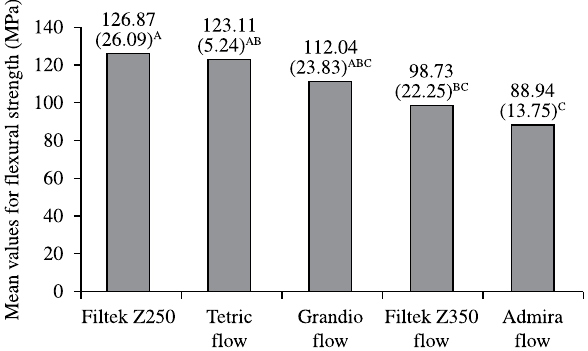
Figure 2. Mean values of FS (MPa) and standard deviations ( ) of the materials studied. Different superscript letters indicates that the materials are statistically different at 5% using the Tukey